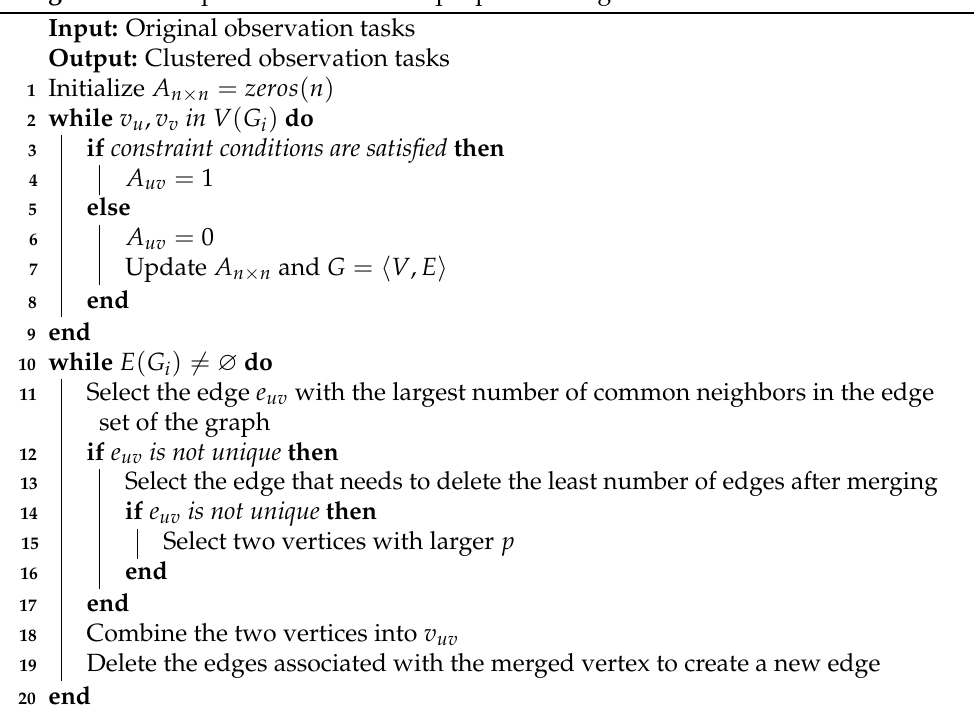
Algorithm 1: Improved minimum clique partition